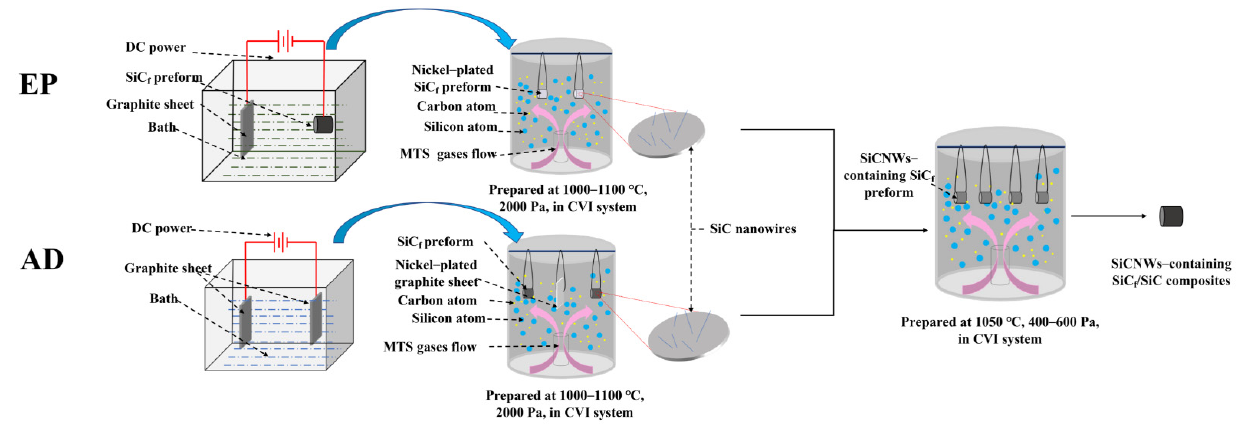
Figure 1. Preparation routes of SiCNW-containing SiC f /SiC composites. Table 1. Parameters for the in-situ growth of SiCNWs and CVI process.